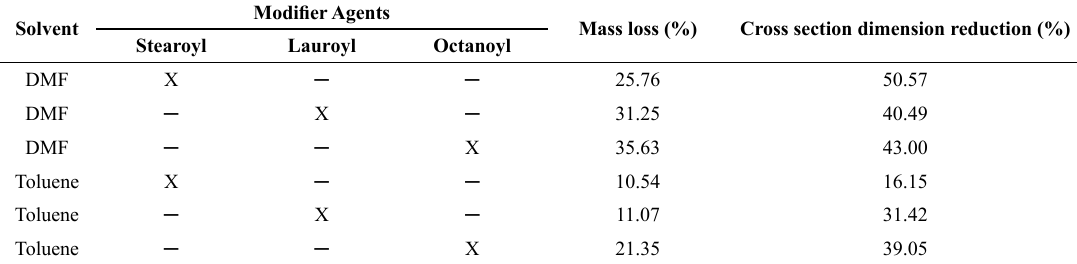
Figure 2. Bending tests of composites: a) test in progress; b) method schema used. Table 3. Mass loss and cross section reduction of the esterified